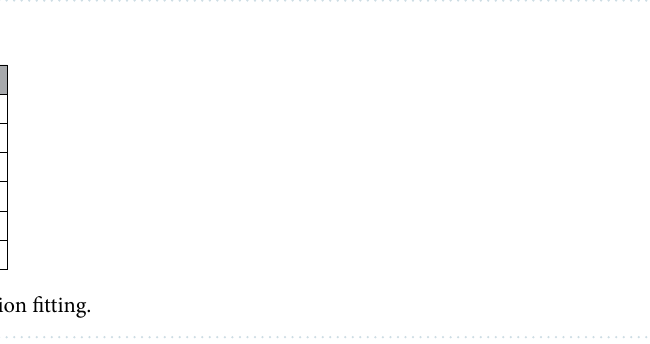
Figure 1. Design of the model employed in this work for simulation of adsorption.